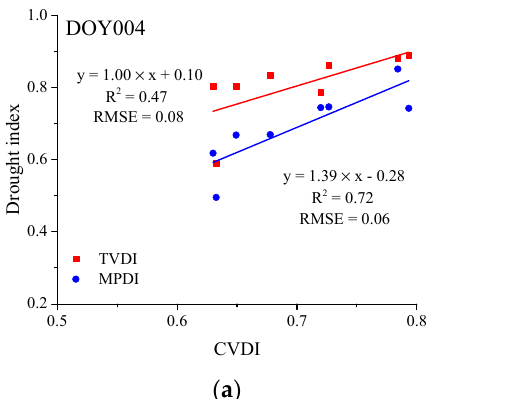
Figure 7. Scatterplots between the three drought indices obtained at the crop sites on DOY004 ( a ), 242 ( b ). 4.3. Temporal Comparison between MPDI, TVDI and CVDI Based on AWRA-L SM Data In this work, the upper AWRA-L SM data are used to compare with CVDI and ground SM measurements at pasture sites. In order to investigate sensitivity between the CVDI values and AWRA-L SM data, the CVDI retrieved at a 5 km resolution was esti- mated based on the MODIS data. Table 4 shows the evaluation results between the CVDI values at 1 km ( x -axis) and 5 km ( y -axis) resolutions as well as their corresponding value range for all of 18 days and 0.01 and 0.05 confidence levels. The R 2 between CVDI 1 km and CVDI 5 km ranges from 0.26 to 0.75 (P < 0.01), while the RMSE ranges from 0.07 to 0.18. The correlation relationship is acceptable on most days considering the complex land cover, except for DOY137, 178 and 203. Table 4 also presents the estimation results between the CVDI 5 km and AWRA-L SM data for the 18 days. Judging from the values of R 2 , a poor correlation relationship is observed on DOY23, 75, 162, 254 and 322 where the R 2 achieved is lower than 0.1, while high values of R 2 are found on DOY137, 176, 203, 274 and 297. Table 4. Estimation results between CVDI 5 km and CVDI 1 km , Australian Water Resource Assess- ment Landscape (AWRA-L) SM data for the 18 days. AWRA-L SM Data RMSE between CVDI 1 km R 2 between CVDI 1 km DOY and CVDI 5 km and CVDI 5 km R 2 RMSE